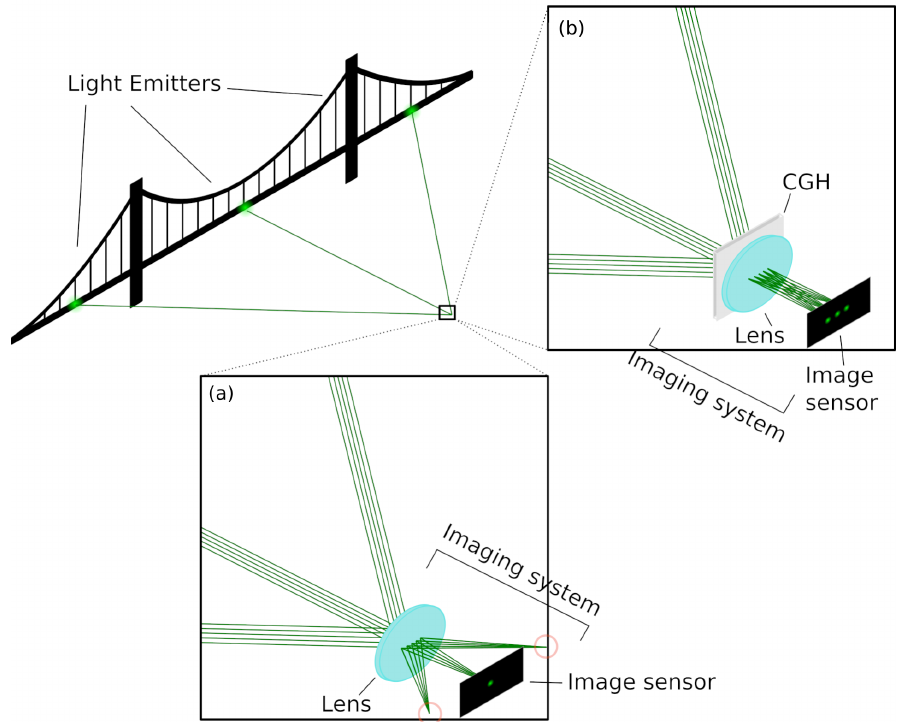
Figure 1. Emitters are attached to one side of the bridge at different locations. ( a ) For conventional imaging with a large focal length, the peripheral emitters are not imaged on the sensor. ( b ) A computer-generated hologram (CGH) deflects the light coming from these emitters toward the image